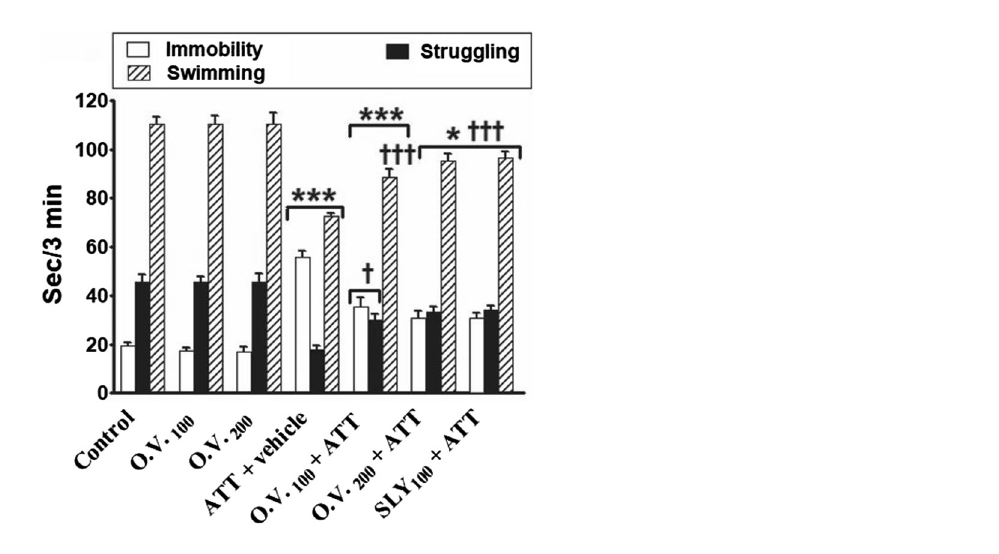
Figure 3. The modulatory effects of O. vulgare on immobility, struggling, and swimming behaviors in FST in the HE rat model. SEM represented by vertical bars. O.V . : Origanum vulgare , SLY: silymarin. * p < 0.05; ** p < 0.01; ***p < 0.001 (vs. the negative control group). † p < 0.05; †† p < 0.01; ††† p < 0.001 (vs. the HE positive control group, which received